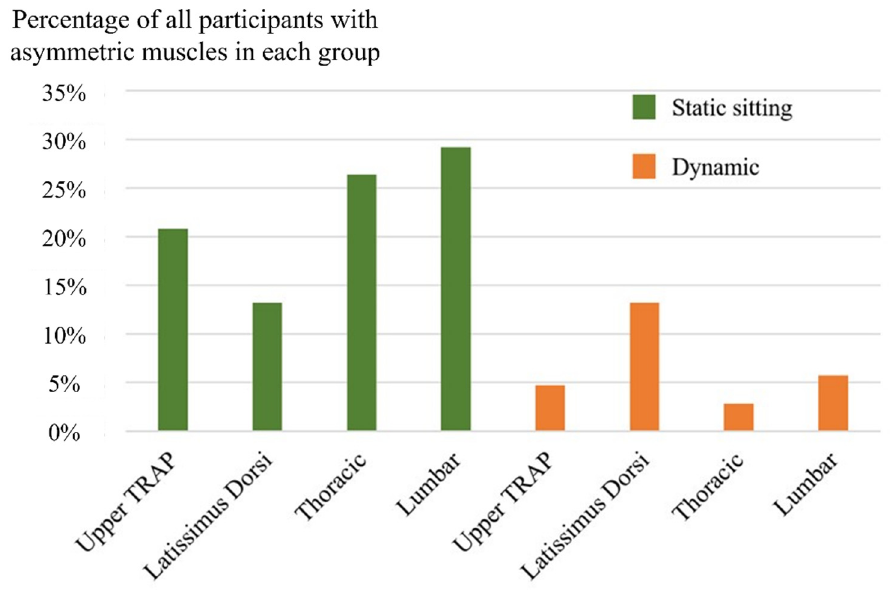
Figure 6. Participants with significantly asymmetric paraspinal muscles.